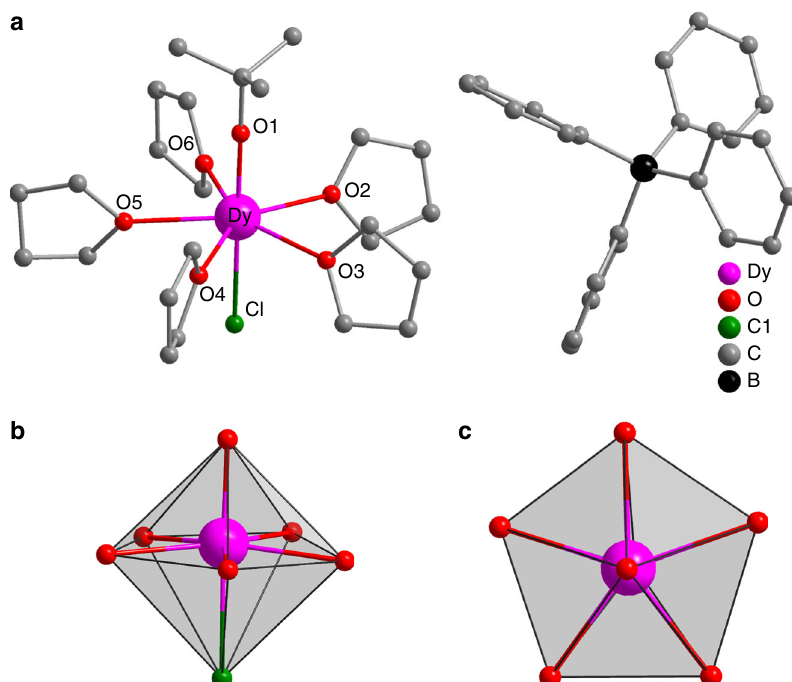
Fig. 1 Molecular structure. a X-ray structure of 1 ; hydrogen atoms and solvent molecules are omitted for clarity. b Side view of coordination polyhedron of 1 . c Top view of coordination polyhedron of 1 . Dysprosium (magenta), oxygen (red), chlorine (green), carbon (grey) and boron